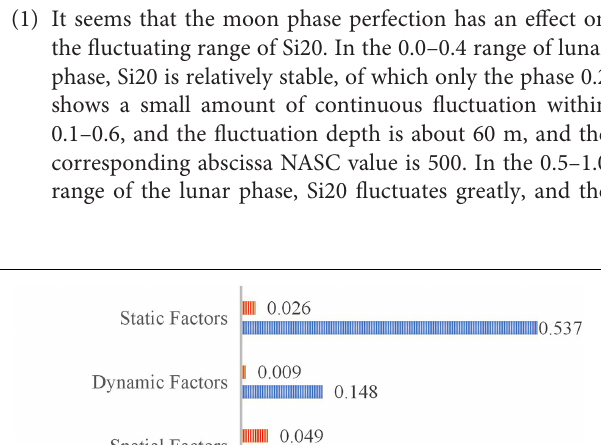
different moon phase perfection ( Figure 9 ). The distribution of Si20 is concentrated in the range of 0.12–0.20 mg/L during the moon of 0.0–0.3, and the distributions in other moon phases are distribution map; however, different Y corresponding to the same variable X shows different scatter distribution patterns.